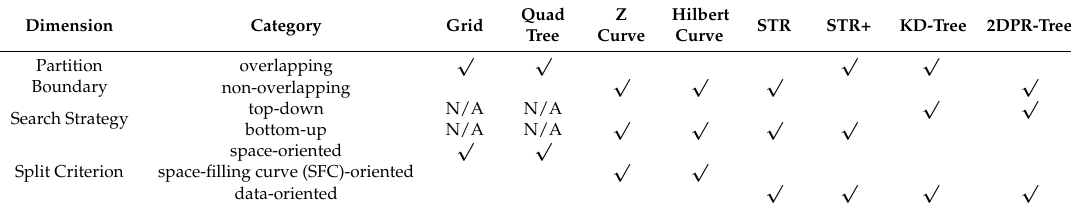
Table 1. A general classification of SpatialHadoop partitioning